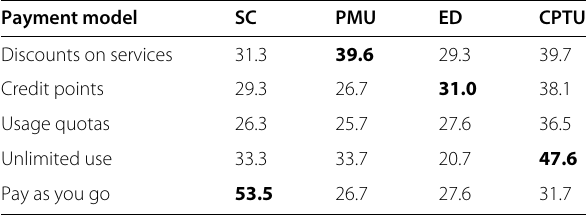
Table 8 Evaluation of Payment